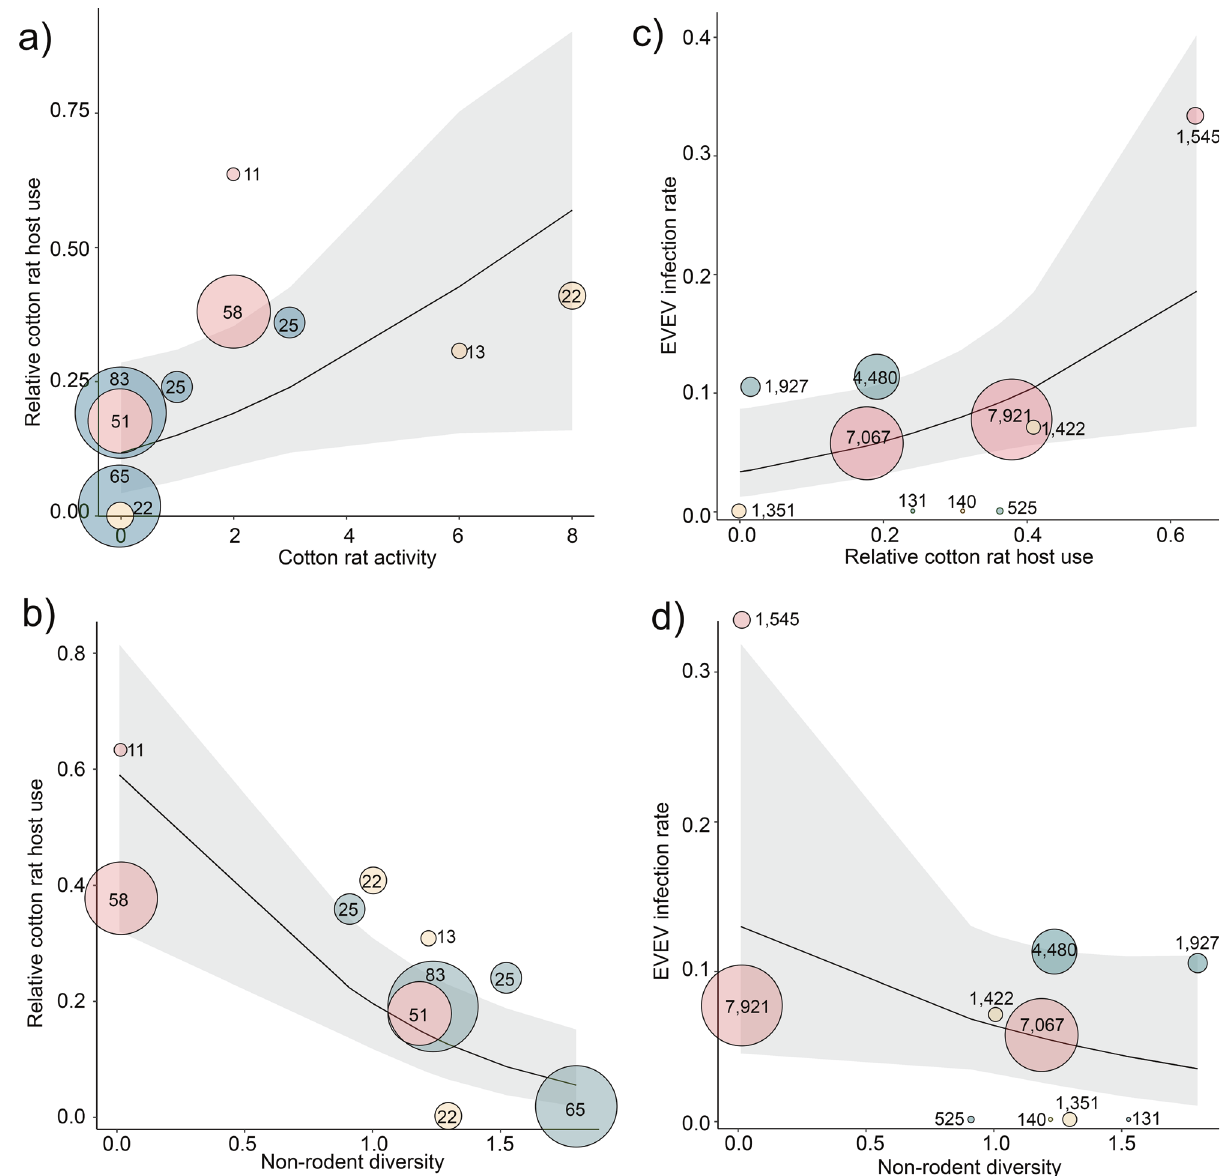
Fig. 2 Variable effect plots from GLMM models of mammal community metric, host use, and Everglades virus infection. Effects of a Cotton rat activity and b Non-rodent diversity on relative cotton rat host use. Effects of c Relative cotton rat host use and d Non-rodent diversity on a proportion of EVEV positive mosquito pools. Shaded areas represent 95% con fi dence intervals. The size of each point represents the number of total blood meals ( a , b ) or the number of females screened by PCR. Model covariates were weighted by sampled size and a site-level random effect was included to account for overdispersion. The colors of points represent high (red), moderate (orange), or low (blue) estimated python presence, based upon estimated relative presence values from the species distribution model